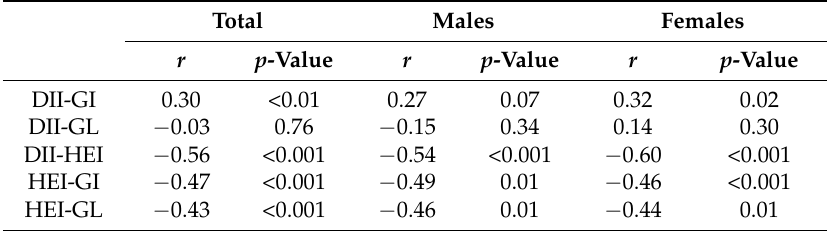
Table 4. Correlation between DII and HEI, Glycemic index (GI), and Glycemic load